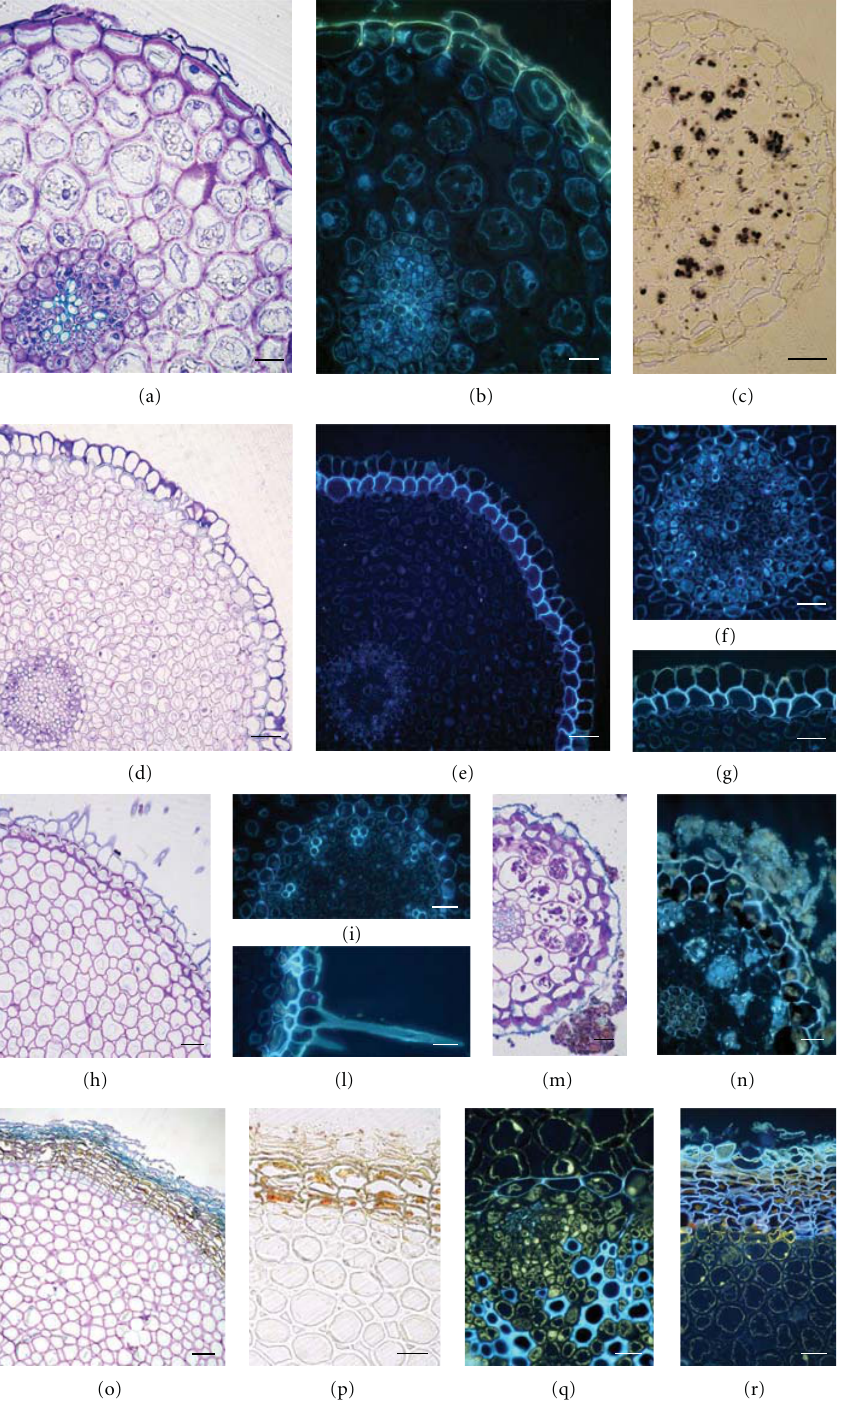
Figure 5: Photomicrographs of root cross-sections of P. palinuri plants developed under controlled conditions (a)–(g) or field-grown (h)–(r) and viewed under light and epifluorescence microscopy: (a)–(c) primary root of a very young plant; (b)–(g) adventitious root of a very young plant; (h)–(n) lateral roots from rhizomes of adult plants; (o)–(r) tie-rod roots from rhizomes of adult plants. UV-microscopy evidenced the blue fluorescence of endodermal Casparian bands (f), (i) and (q) of exodermal cell walls (e), (g), (n), and of subepidermal suberized layers (r). Phenolic compounds are evidenced by the yellow fluorescence (q) and (r). Bars are 20 μ m in (a), (b), (f), (g), (i), (l)–(n), and (q), 50 μ m in (c)–(e), (h), (p), (r), and 100 μ m in